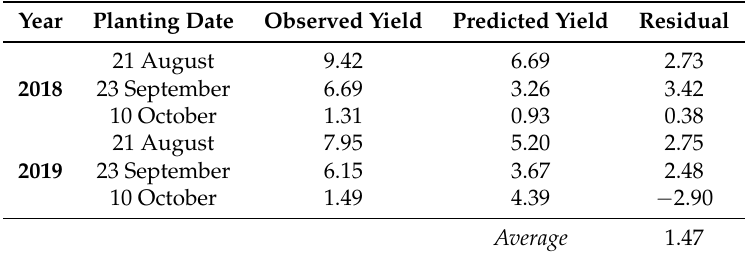
Table A2. Residual Analysis of Yield for 2018 and 2019 for the